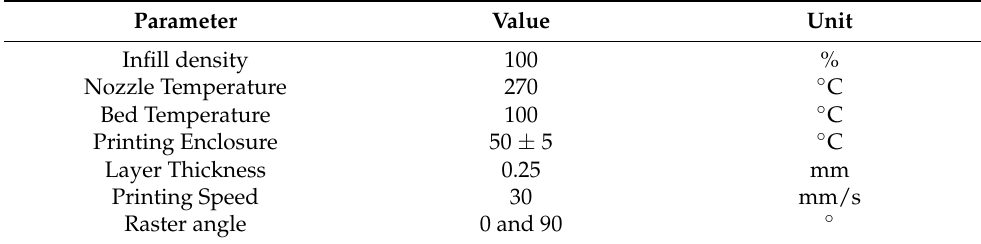
Table 2. Printing Processing